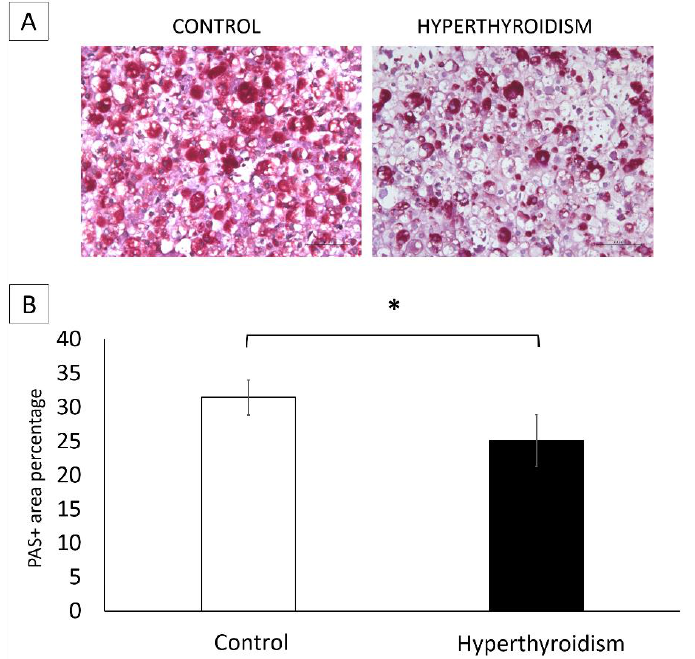
Figure 5. ( A ) Photomicrograph of the 3D culture of chondrocytes derived from the femoral epiphysis of control newborn rats and those exposed to maternal hyperthyroidism, with a reduction in PAS+ areas in the hyperthyroidism group at 21 days. Periodic acid-Schiff staining (PAS). 100×. ( B ) Percentage of PAS+ areas in the 3D culture of chondrocytes derived from the femoral epiphysis of control newborn rats and those exposed to maternal hyperthyroidism at 21 days. * p < 0.05.